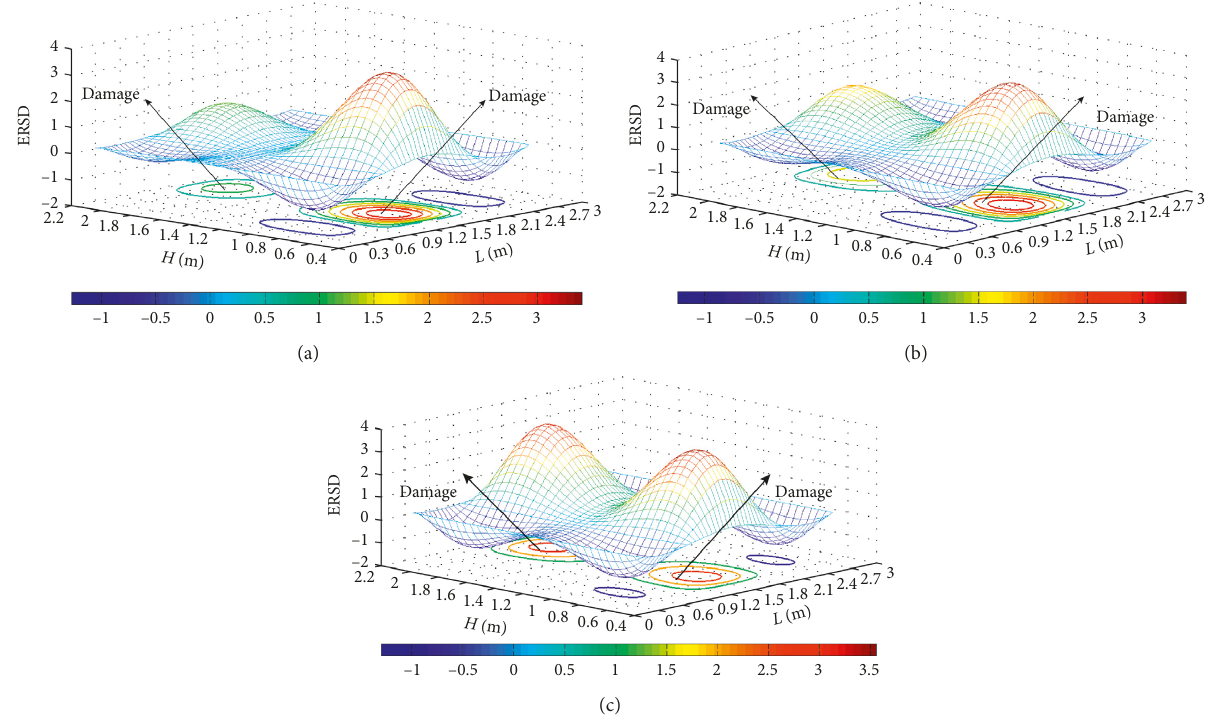
Figure 16: Trend surface of ERSD in model tests (two